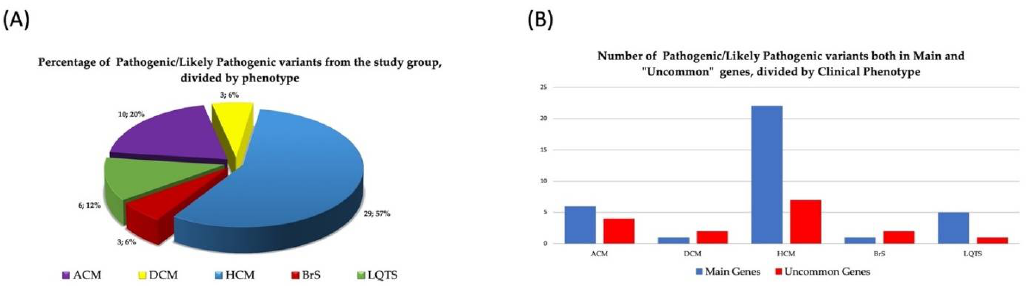
Figure 3. ( A ) Percentage and number of pathogenic or likely pathogenic variants collectively